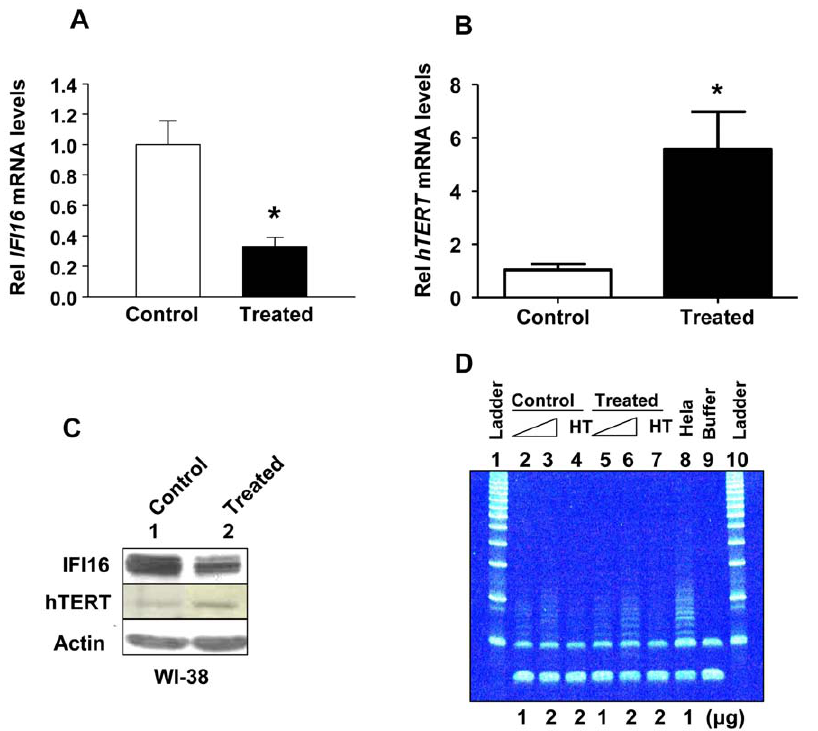
Figure 1. Reduced expression levels of IFI16 protein in aphidicolin-treated human normal diploid fibroblasts are associated with increased expression levels of the hTERT and telomerase activity. ( A and B ) Total RNA isolated from untreated (control) or aphidicolin (5 m g/ ml for 24 h) treated young WI-38 fibroblasts was subjected cDNA synthesis followed by quantitative real-time PCR using the TaqMan assay for the IFI16 gene (A) or hTERT gene (B). Results are mean values of triplicate experiments and the error bars represent standard deviation ( * p , 0.05 ). ( C ) Total protein extracts prepared from untreated (lane 1) or aphidicolin (5 m g/ml for 24 h) treated (lane 2) young WI-38 fibroblasts were subjected immunoblotting using antibodies specific to the indicated proteins. ( D ) Extracts containing the indicated amounts ( m g) of proteins from control (lanes 2–4) or aphidicolin-treated (lanes 5–7) young WI-38 cells were subjected to TRAPeze assays without any treatment (lanes 2, 3, 5, and 6) or after heat treatment (lanes 4 and 7) to detect the telomerase activity. As controls, extracts from HeLa cells (lane 8) or buffer alone (lane 9) were also included in the assay. The reaction products were subjected to native polyacrylamide gel electrophoresis along with DNA fragments of increasing length as size markers